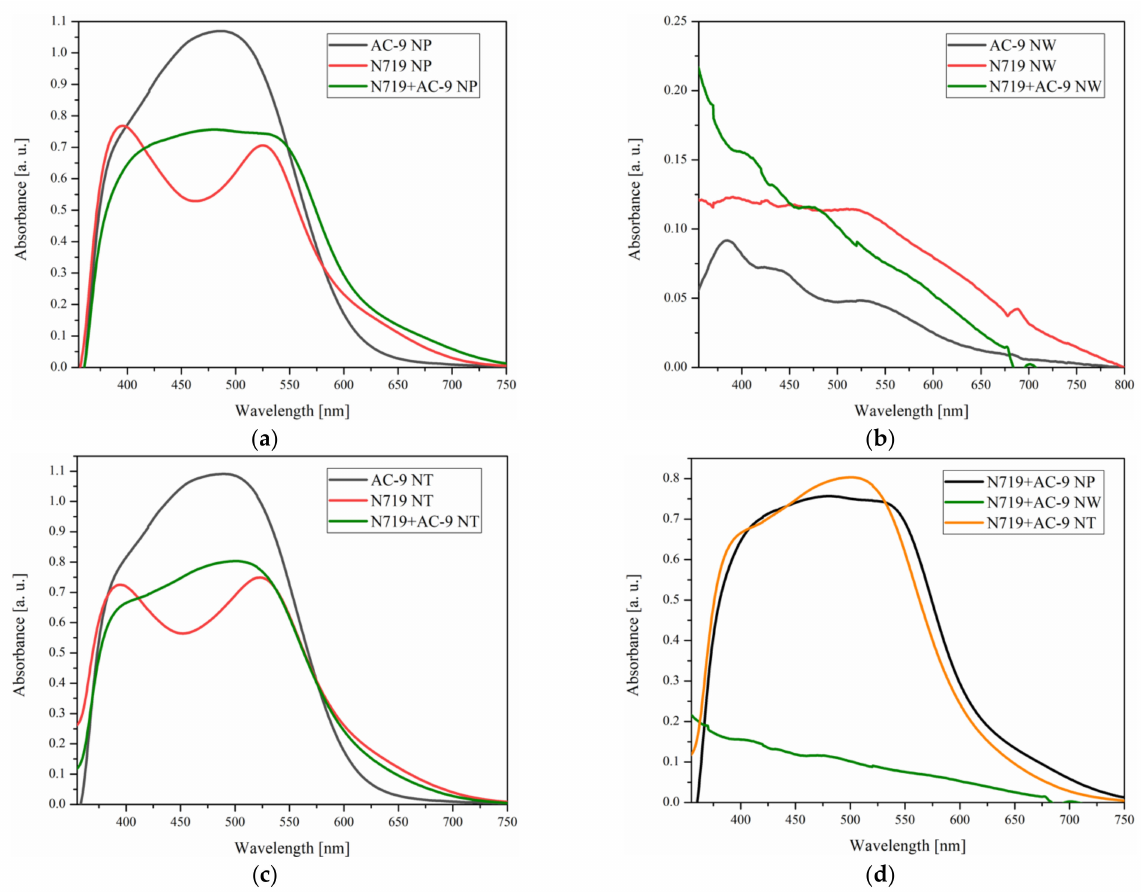
Figure 2. The UV-Vis absorption spectra of tested TiO 2 substrates consisting of ( a ) only TiO 2 nanoparticles (NP), ( b ) TiO 2 nanoparticles with nanowires (NW) and ( c ) nanoparticles with nanotubes (NT); ( d ) different TiO 2 nanostructural layers containing mixtures of dyes N719 and